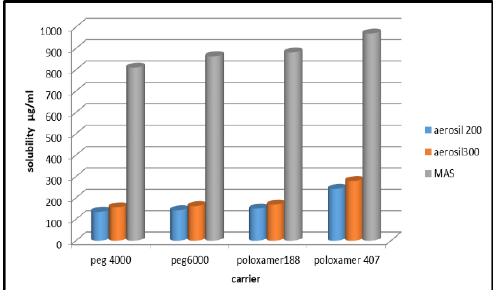
Figure2. Effect of adsorbent and carrier type of ATR SDA at ratio (1:1:1) on the solubility of ATR in distilled water at 25°C Determination of percentage yield (PY %) and